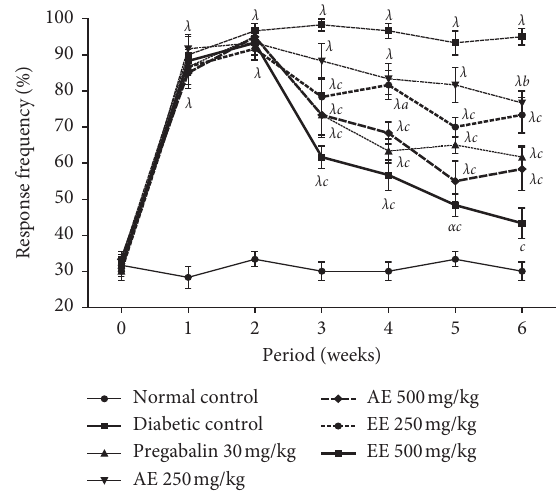
Figure 1: Effects of the aqueous (AE) and ethanol (EE) extracts of Dissotis thollonii on mechanical allodynia induced by Von Frey. Values are expressed as mean ± SEM for six animals and analyzed by two-way ANOVA followed by Bonferroni post hoc test. α p < 0 . 05, λ p < 0 . 001 when compared with the normal control and a p < 0 . 05, b p < 0 . 01, c p < 0 . 001 when compared with the diabetic control.